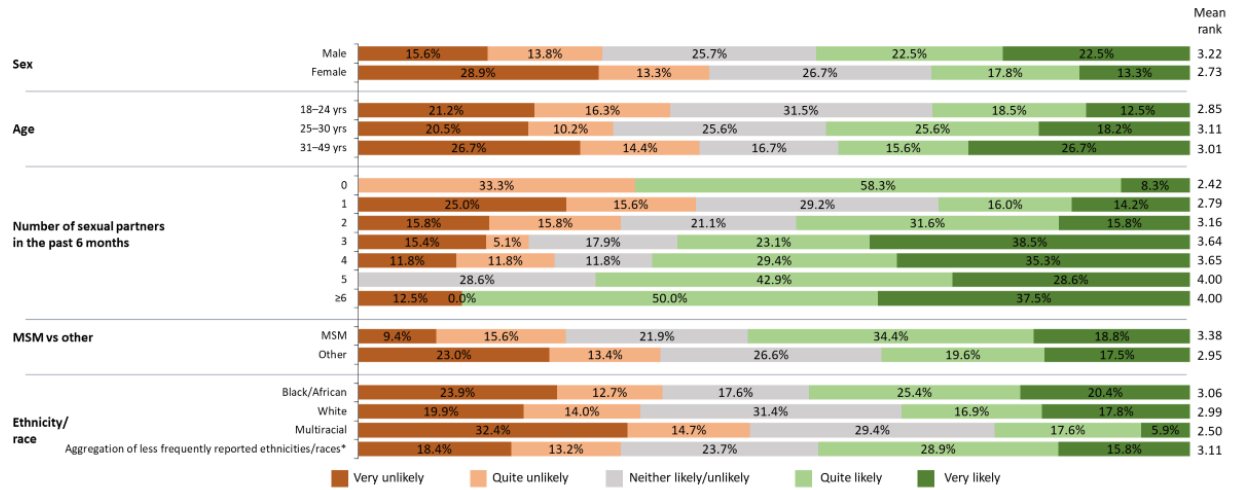
Figure 5. Willingness to participate in a gonorrhea vaccine clinical trial according to sex, age, number of sexual partners in the previous 6 months, MSM versus other, and ethnicity/race; ( N = 450). The number of sexual partners and sex were significantly associated with the likelihood to enroll in a gonorrhea vaccine trial (Kruskal–Wallis p < 0.001 and p = 0.001, respectively). Very unlikely = I would be very unlikely to consider taking part; quite unlikely = I would be quite unlikely to consider taking part; neither likely/unlikely = I would neither be likely nor unlikely to consider taking part; quite likely = I would be quite likely to consider taking part; very likely = I would be very likely to consider taking part. MSM, men who have sex with men. * Less frequently reported ethnicities/races = American Indian, Alaskan Native, Asian, Native Hawaiian, Pacific Islander, Hispanic, Latino, and